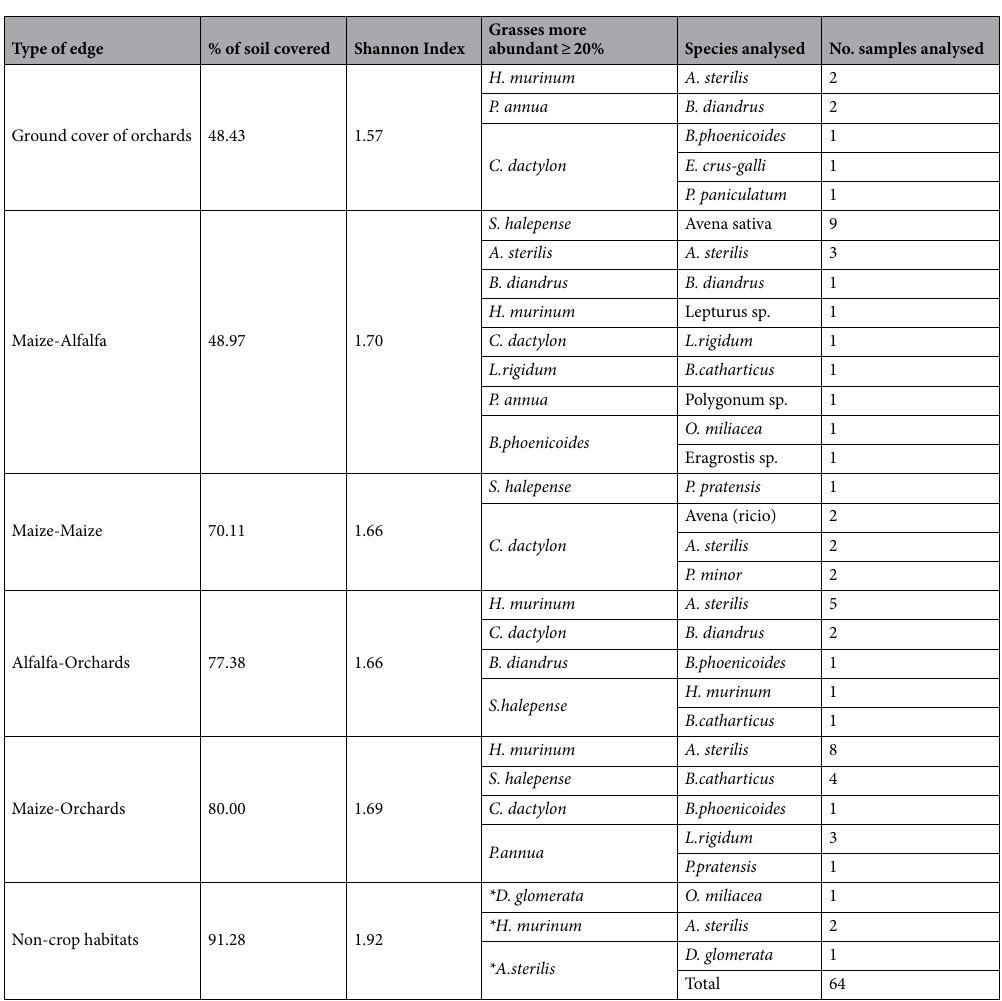
Table 2. Types of edges sampled using the Braun-Blanquet scale. *Cover < 15%. Composition of plant species, cover abundance and the H’ according to the field edges of maize-neighbouring crops. The table shows the most abundant grass (≥ 20% of plant cover) and species analysed by selective isolation of dsRNA from each type of